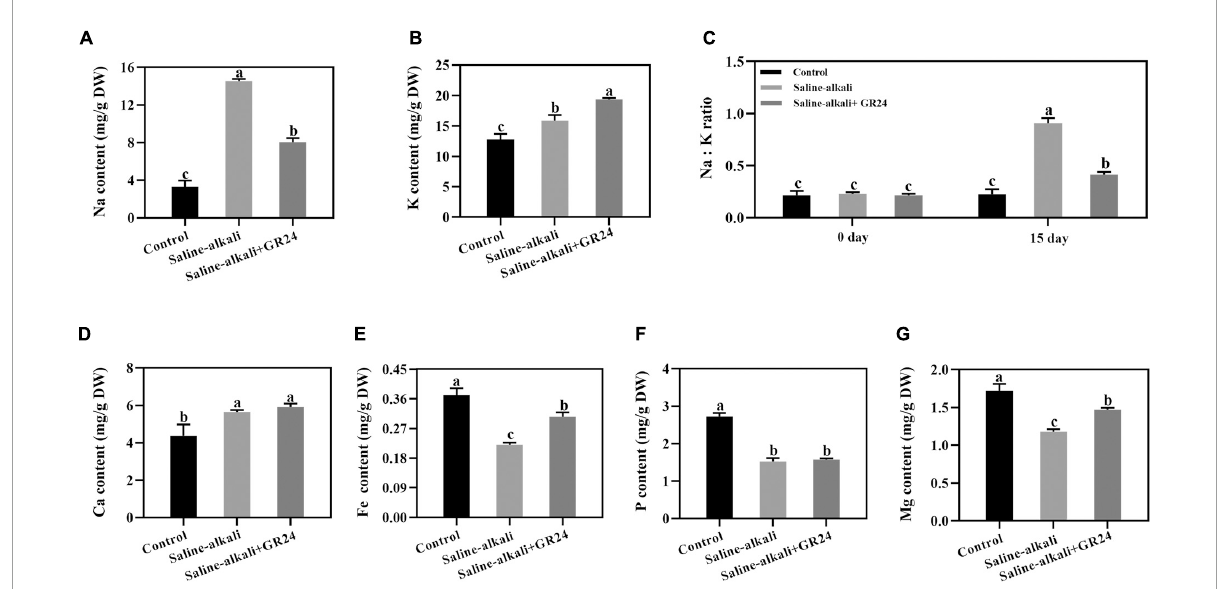
FIGURE5 Effects of GR24 treatment on Na content (A) , K content (B) , and Na + /K + ratio (C) , Ca content (D) , Fe content (E) , P content (F) , Mg content (G) under salinity-alkalinity stress. The data represent the mean ± SD of three biological replicates. Different lowercase letters indicate significant differences according to Fisher’s least significant difference ( P <